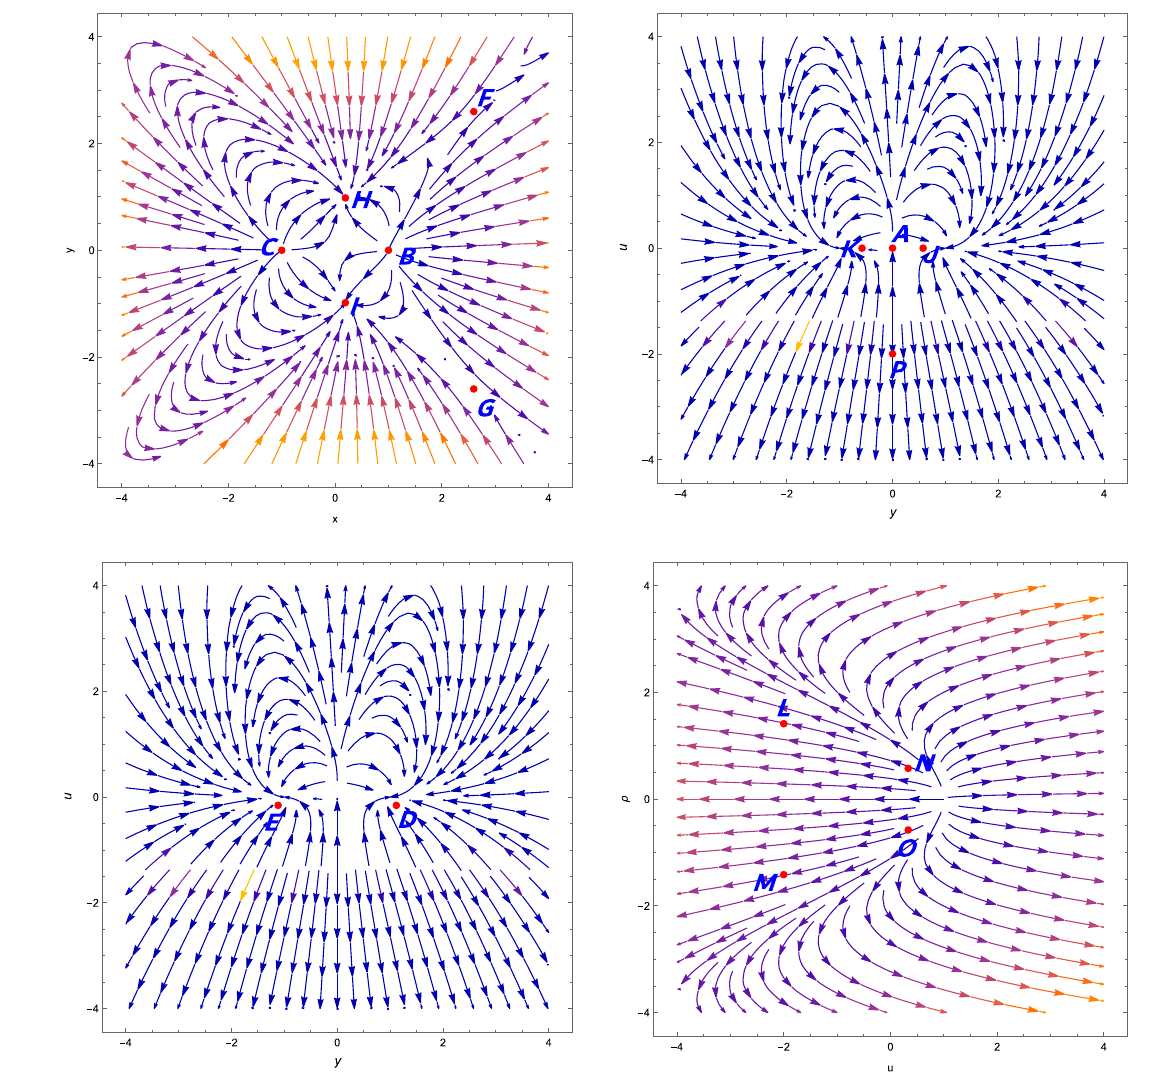
Fig. 5 Phase portrait for above dynamical system Eqs. (76–80), the upper left plot is for u = 0, ρ = 0, λ = having parameter values x = 0, ρ = 0„ σ = 1, α = 1 . 1. The lower